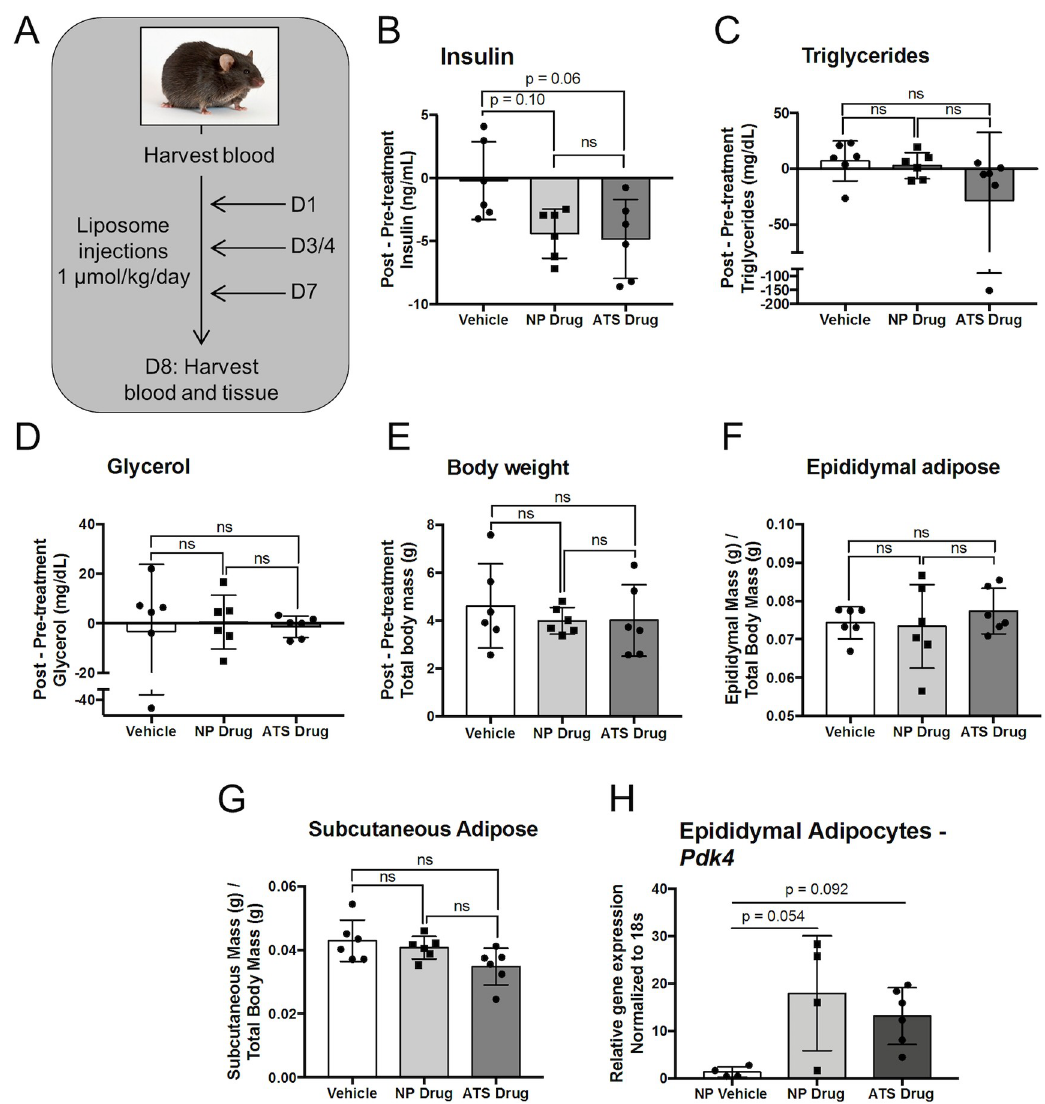
Fig 2. ATS-targeted tesaglitazar-loaded liposomes do not improve metabolic outcomes over untargeted tesaglitazar liposomes. Male ob/ob mice were injected three times over the course of one week with liposomes that contained vehicle or tesaglitazar at a concentration of 1 μ mol of tesaglitazar/kg/day without peptide (NP drug) or with the ATS peptide (ATS drug) (A). Plasma isolated from blood harvested before and after treatment was utilized to measure circulating levels of insulin (B), triglycerides (C), and glycerol (D) and changes from pre-treatment to post-treatment were calculated. The body weight of each animal was also measured before and after treatment and the change in body weight was calculated (E). After treatment, whole epididymal (F) and subcutaneous (G) adipose depots were weighed and tissue weight was normalized to the post-treatment body weight of each mouse. RNA extracted from epididymal adipocytes was utilized to measure relative mRNA expression levels of Pdk4 (H). � p < 0.05, �� p < 0.01, Kruskal-Wallis